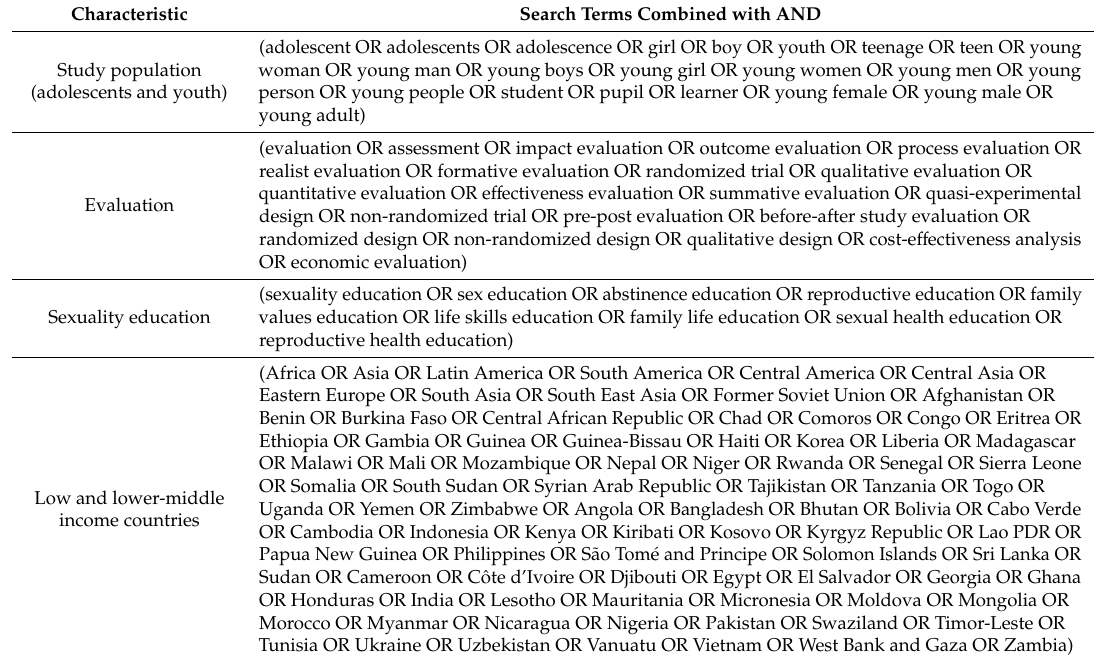
Table 1. Search terms